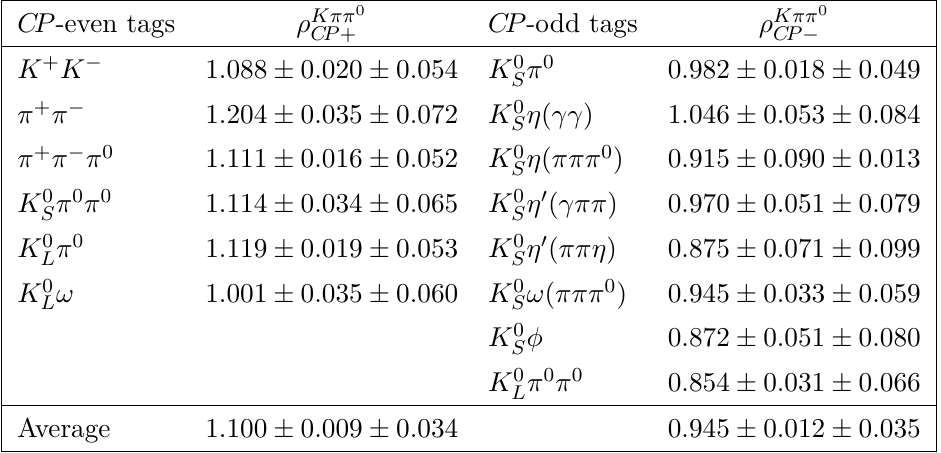
shown for individual tags, and averaged. The uncertainties are statis- Table 9 . Results for ρ Kππ 0 CP ± tical and systematic, respectively.